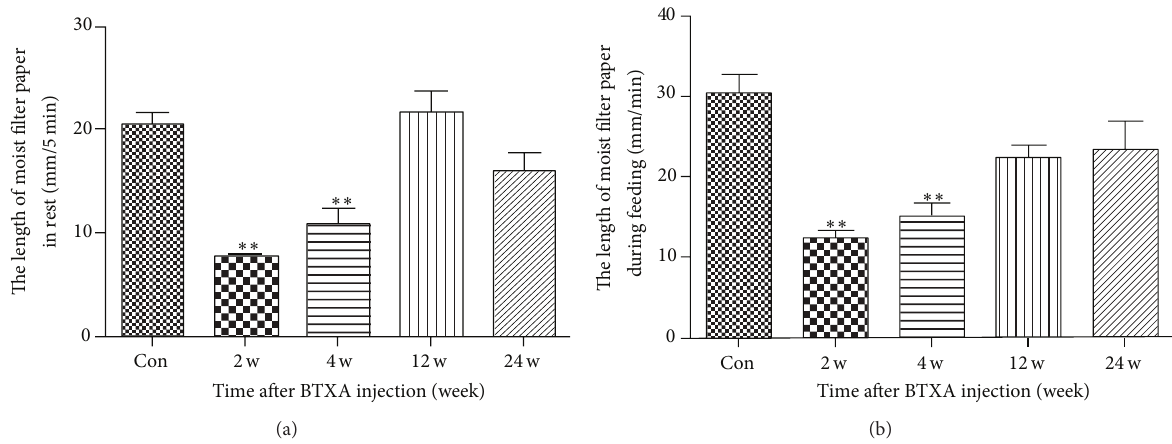
Figure 2: Secretion output of transplanted SMG after BTXA injection. (a) Secretion output of transplanted SMG at rest after BTXA injection in five minutes. (b) Secretion output of transplanted SMG during feeding after BTXA injection in one minute. Values are means ± SE from six independent experiments. ∗∗ 𝑝 < 0.01 versus control group.